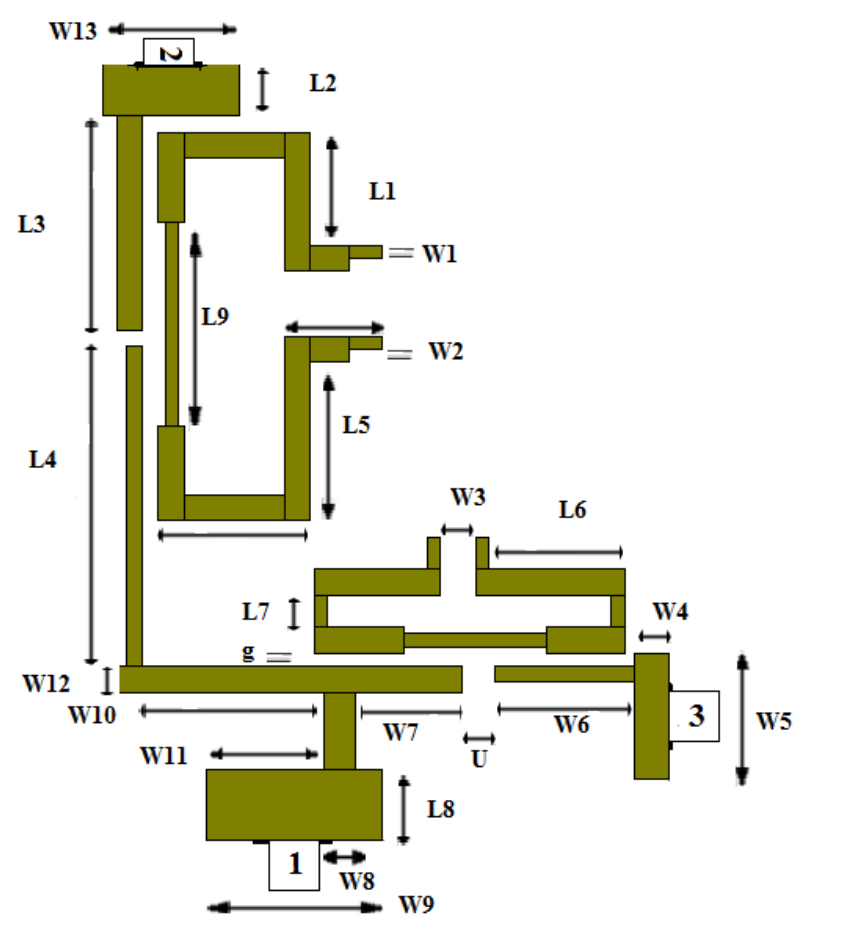
Figure 6. The structure and dimensions of the microstrip diplexer based on Kappa substrate, all dimensions in mm unit. L1 = 3.5, L2 = 0.8, W1 = 0.2, W2 = 0.2, L3 = 6.6, L4 = 9.9, L5 = 4.9, L6 = 4.2, W3 = 1.1, W4 = 1.1, W4 = 1.1, W5 = 3.9, W6 = 4.3, W7 = 3.3, U = 1, g = 0.1, W8 = 1, W9 = 5.4, W10 = 5.6, W11 = 3.6, W12 = 0.8, L7 = 1, L8 = 2.2, L9 = 6.3.